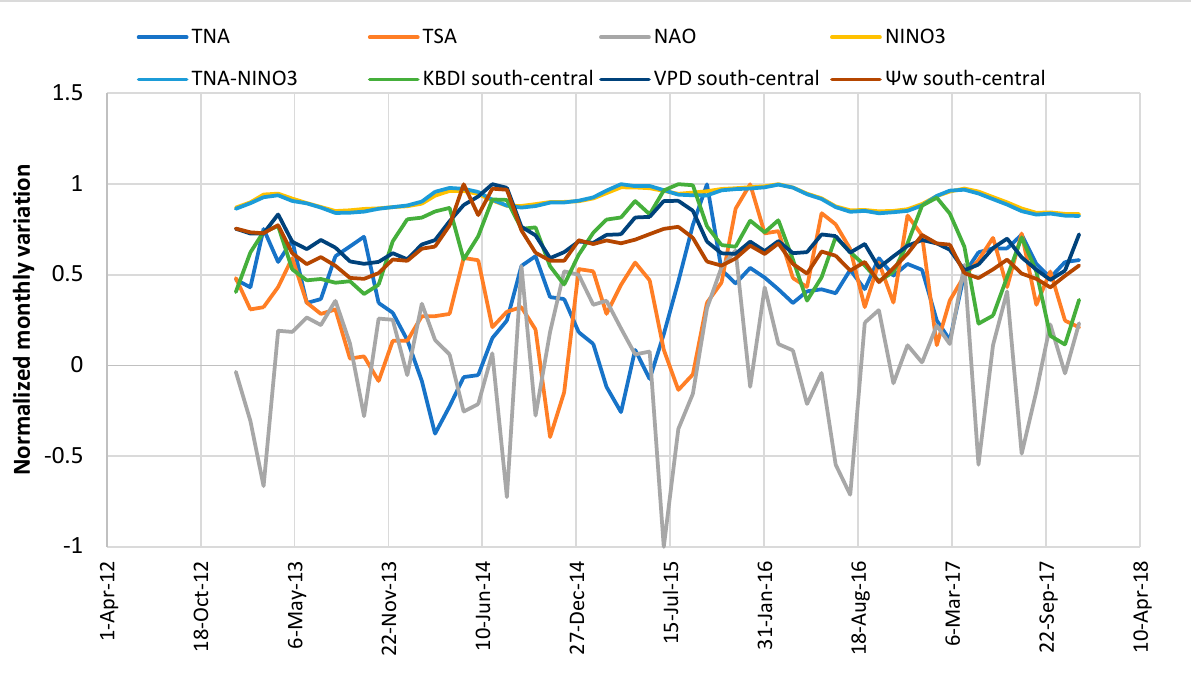
Figure 6. Normalised monthly variation of south-central VPD, KBDI, Ψ w , and large-scale climate indices TNA, TSA, NAO, NINO3 and TNA—NINO3 time series for 2013–2017.